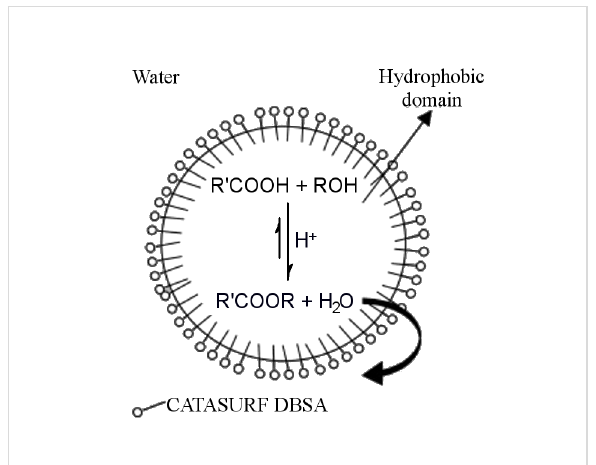
Figure 8: Schematics for the polycondensation reaction between hydrophobic alcohols and carboxylic acids surrounded by the aqueous continuous phase (not to scale for the surfactant) (reprinted with permission from [13]. Copyright (2003)